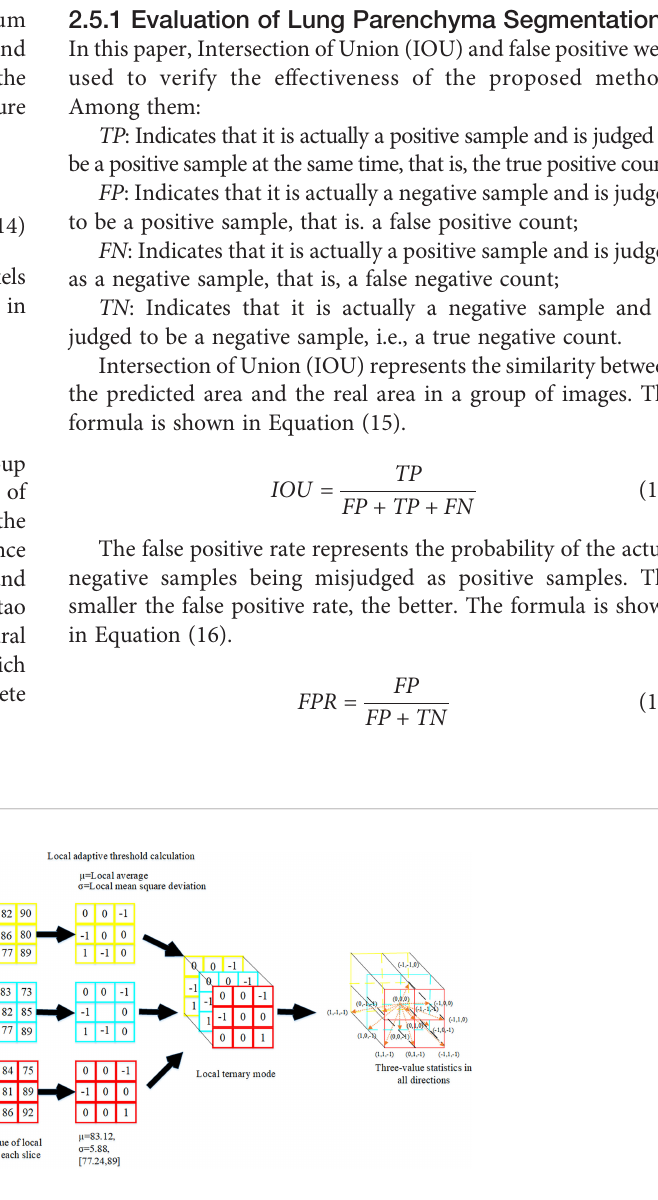
FIGURE 4 | Extraction process of texture features of pulmonary